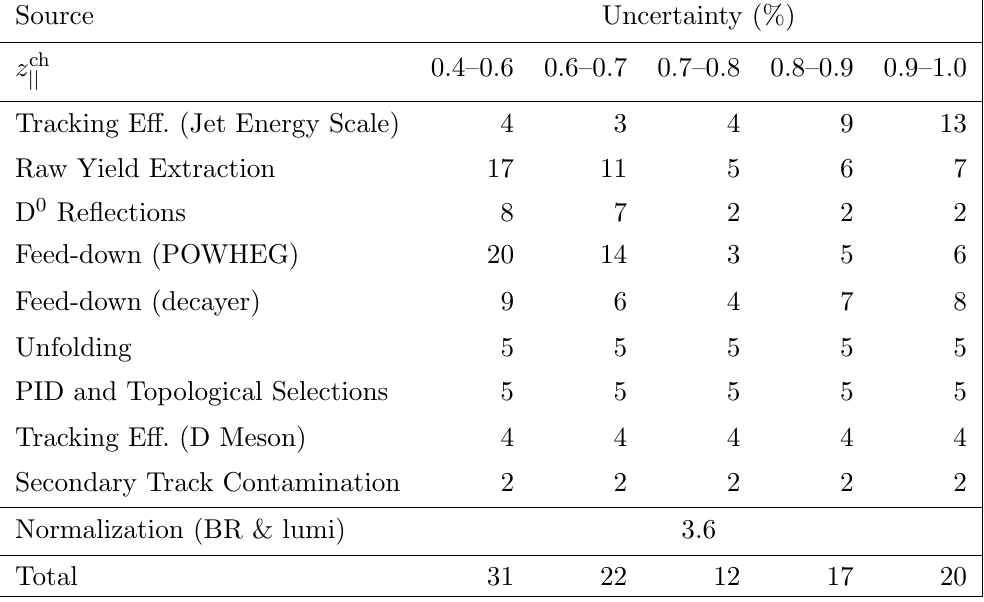
Table 3 . Summary of systematic uncertainties as a function of z ch